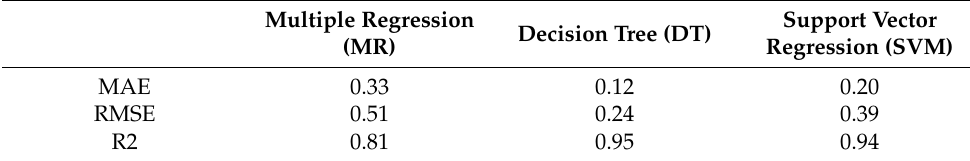
Table 4. The performance of prediction